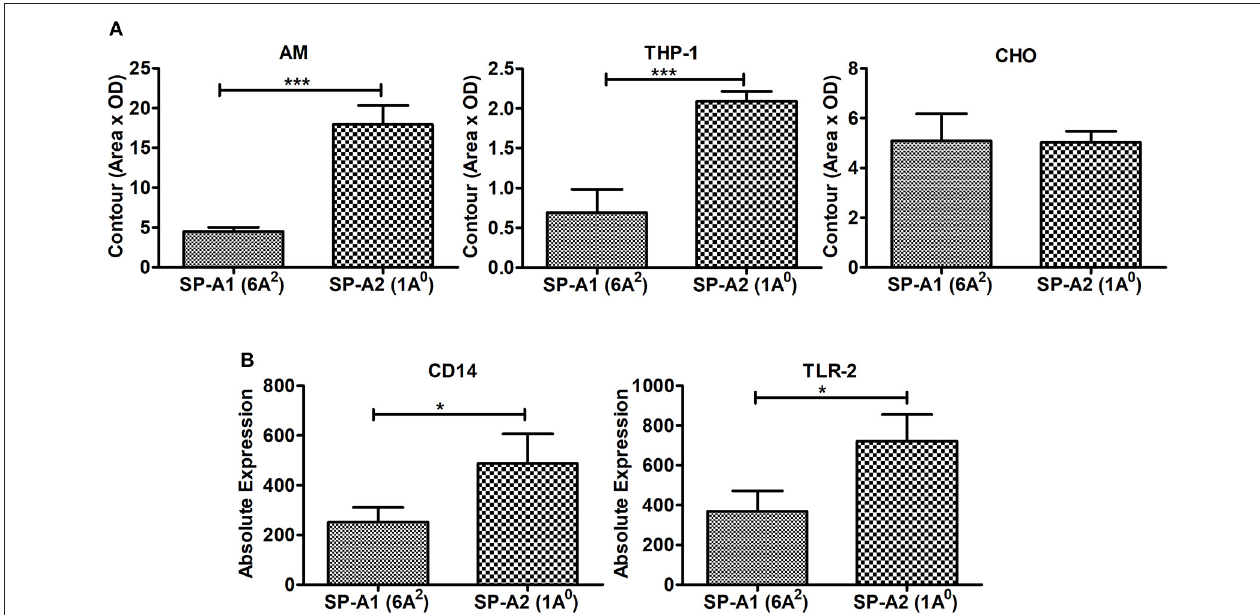
FIGURE 8 | Binding of SP-A1 (6A 2 ) and SP-A2 (1A 0 ) variants to phagocytic and non-phagocytic cells and expression of cell surface proteins in AMs of SP-A1 (6A 2 ) and SP-A2 (1A 0 ) mice. (A) depicts binding of rat AM and two cell lines (THP-1, a macrophage-like and phagocytic and the other CHO, non-phagocytic) to SP-A variants expressed by stably transfected mammalian cell lines. Cells (AM, THP-1, and CHO) were adhered to 96-well tissue culture plates and incubated with purified SP-A2 (1A 0 ) and SP-A1 (6A 2 ). Cells were then washed and lysed and the SP-A content of the lysates determined by Western dot blot and densitometry. A significant increase in binding of SP-A2 vs. SP-A1 ( p = 0.0007) to AM was seen as was for the phagocytic THP-1 cells ( p = 0.0015), but no differences were observed with the non-phagocytic CHO cells. (B) Depicts expression of SP-A binding proteins from AMs of hTG SP-A1 (6A 2 ) and SP-A2 (1A 0 ) mice. Bronchoalveolar lavage was performed on hTG SP-A2 (1A 0 ) and SP-A1 (6A 2 ) mice. AM were stained for SP-A binding proteins CD14 and TLR2 and analyzed by flow cytometry. A significant increase in expression of CD14 ( p = 0.036) and TLR2 ( p = 0.022) was seen in SP-A2 (1A 0 ) AM vs. SP-A1 (6A 2 ) AM. * p < 0.05, *** p <